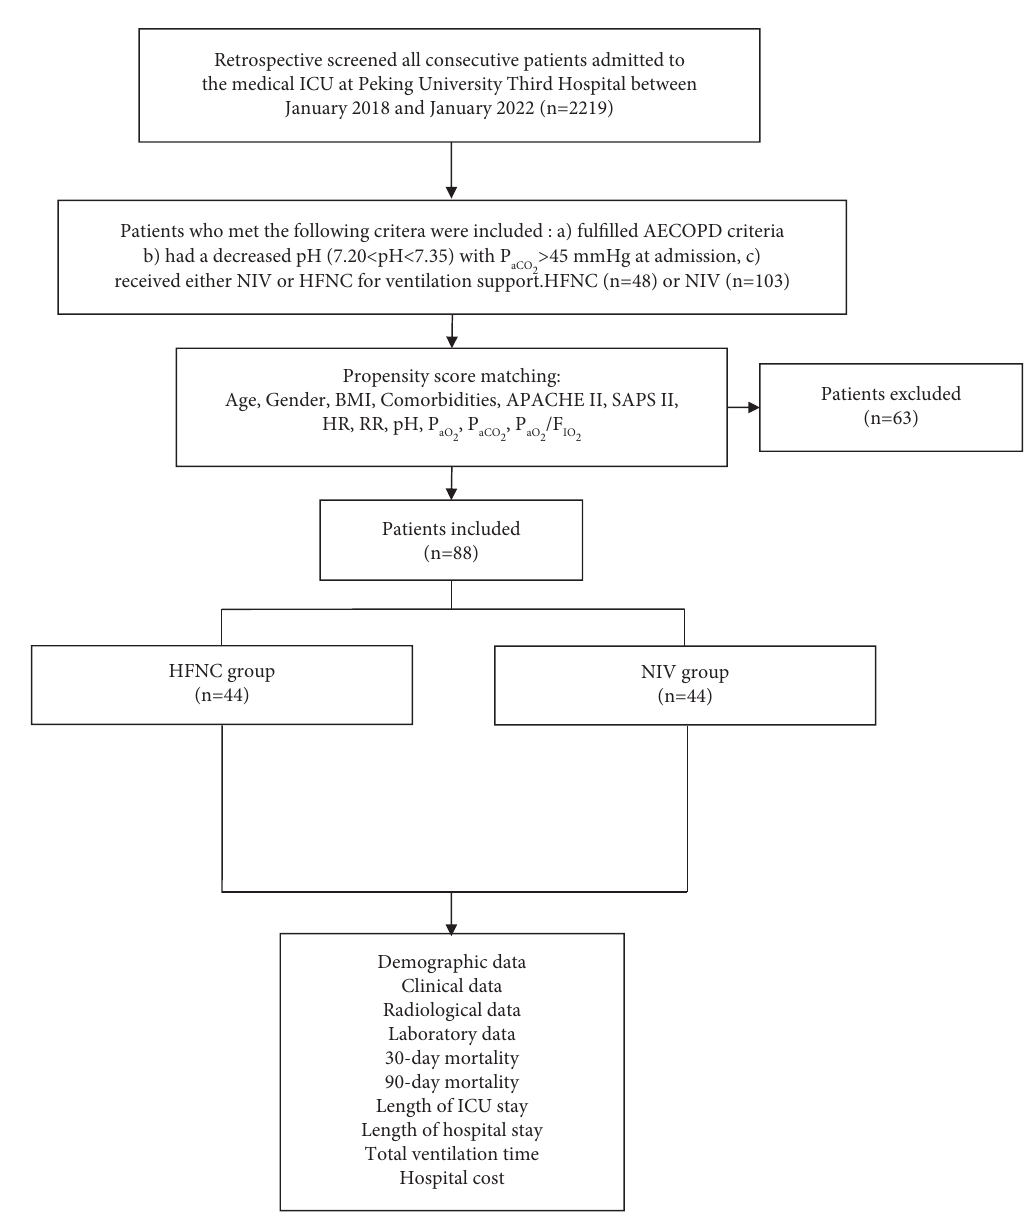
Figure 1: Patient selection diagram based on propensity score